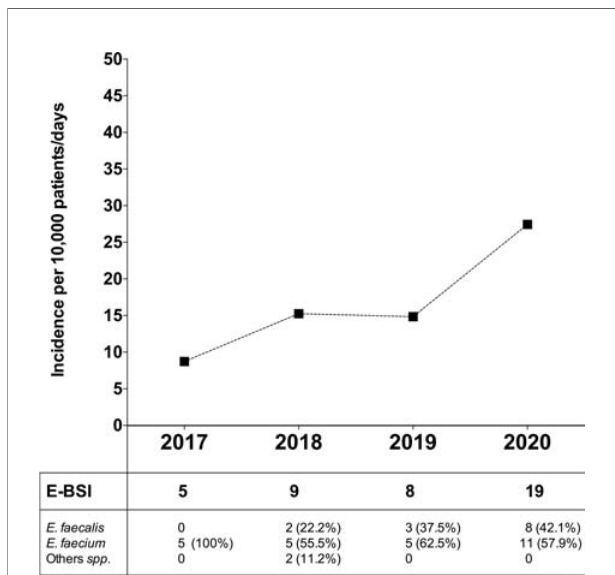
FIGURE 6 | Incidence of bloodstream infection due to Enterococcus spp. in critically ill patients during the COVID-19 pandemic and in the previous 3 years. Top, Incidence rate of ICU-acquired enterococcal-BSI (E-BSI) per 10,000 patient-days during the COVID-19 pandemic and in the previous 3 years. The incidence rate was evaluated over the same 4-month period (January-April) since 2017 to 2020. Bottom, Number of cases of BSI due to E. faecium , E. faecalis and others ( Enterococcus spp.) over the studied